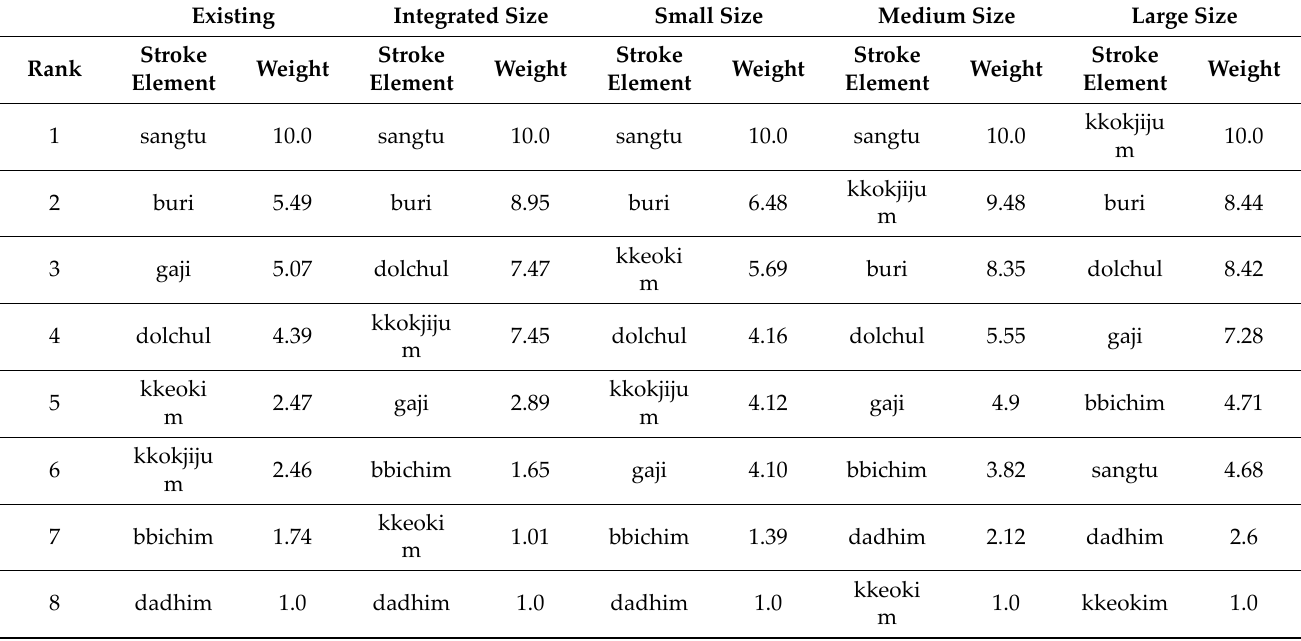
Table 14. Results of converting stroke element influence values into